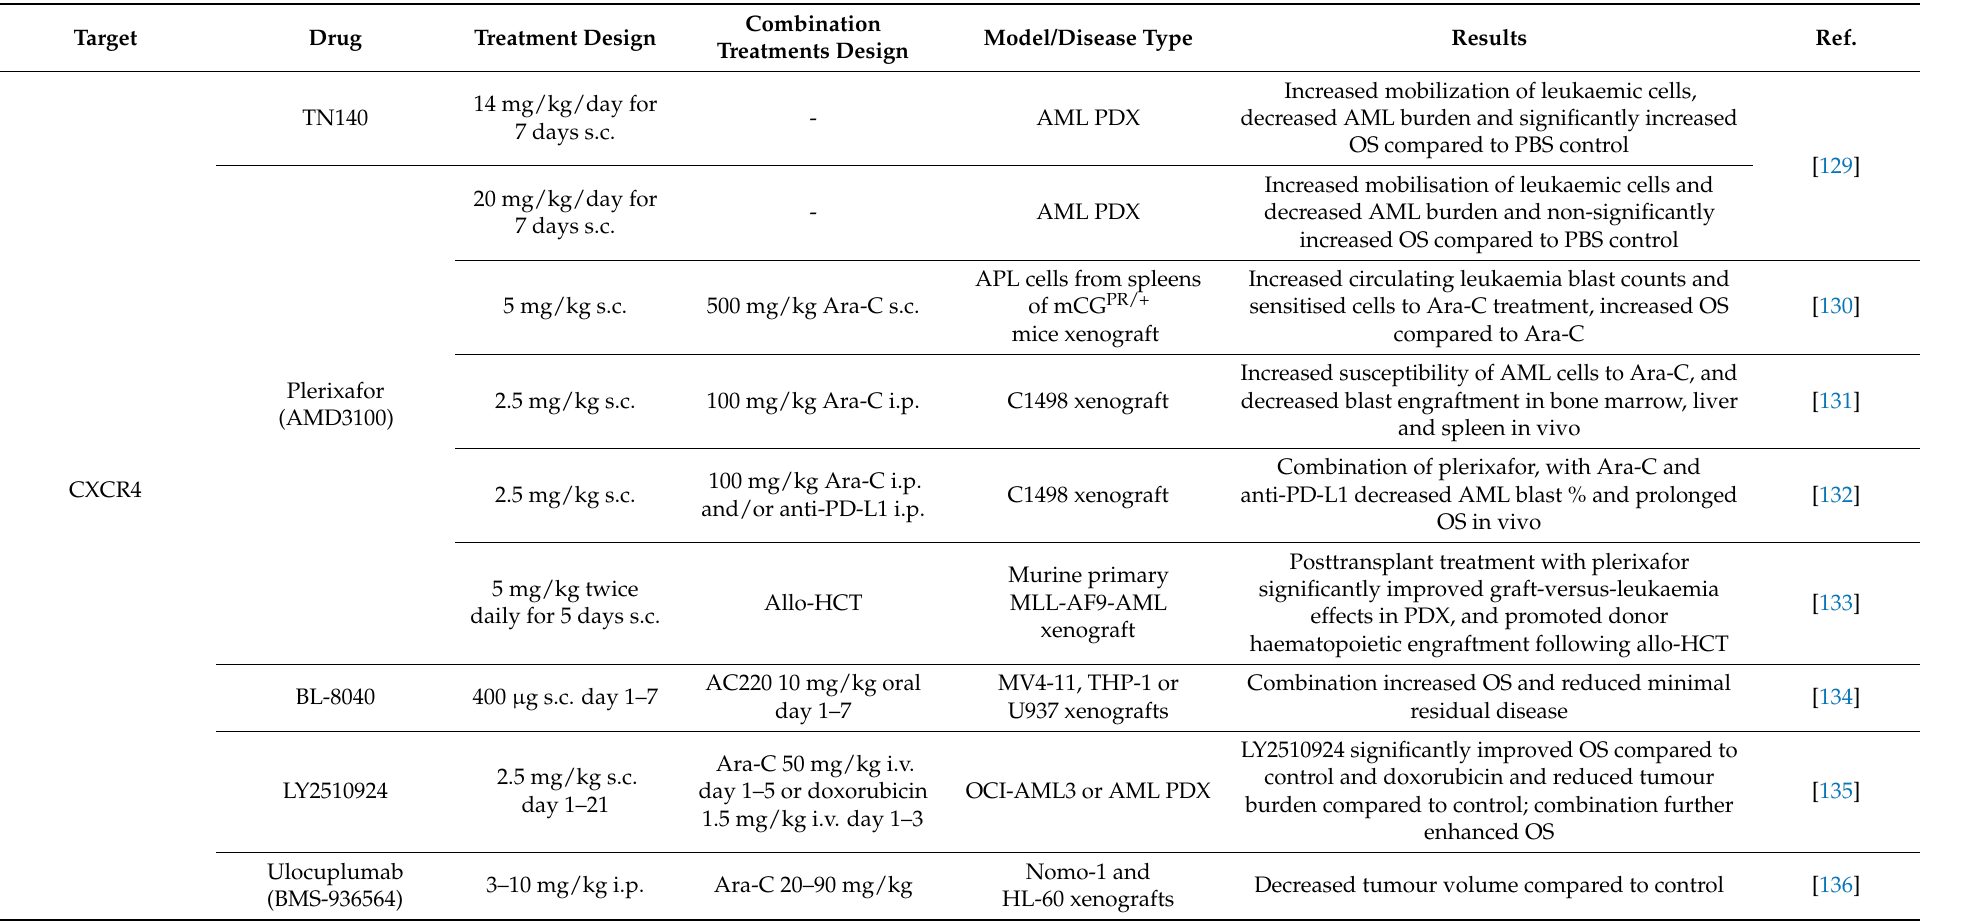
Table 1. Summary of strategies for targeting the bone marrow microenvironment as a treatment for AML that have been examined experimentally in